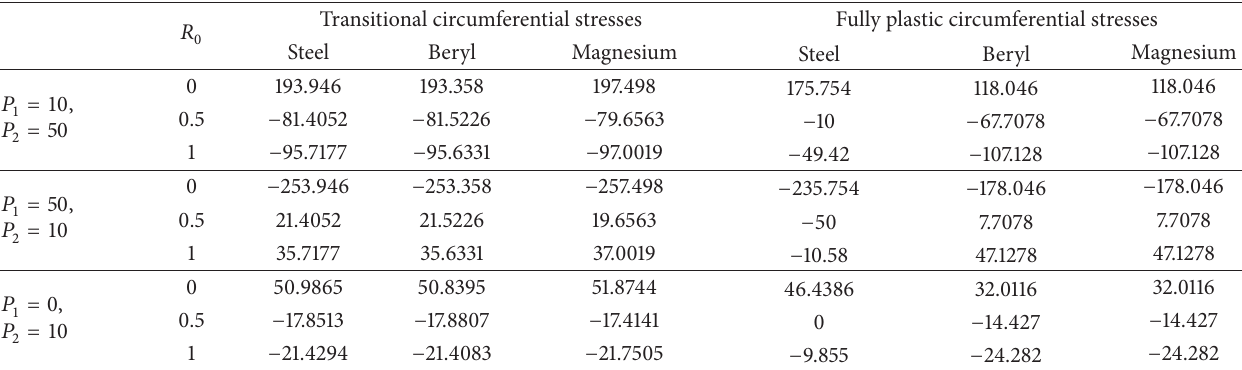
Table 5: Circumferential stresses for different pressures for isotropic (steel) and transversely isotropic material (beryl and steel). 𝑅